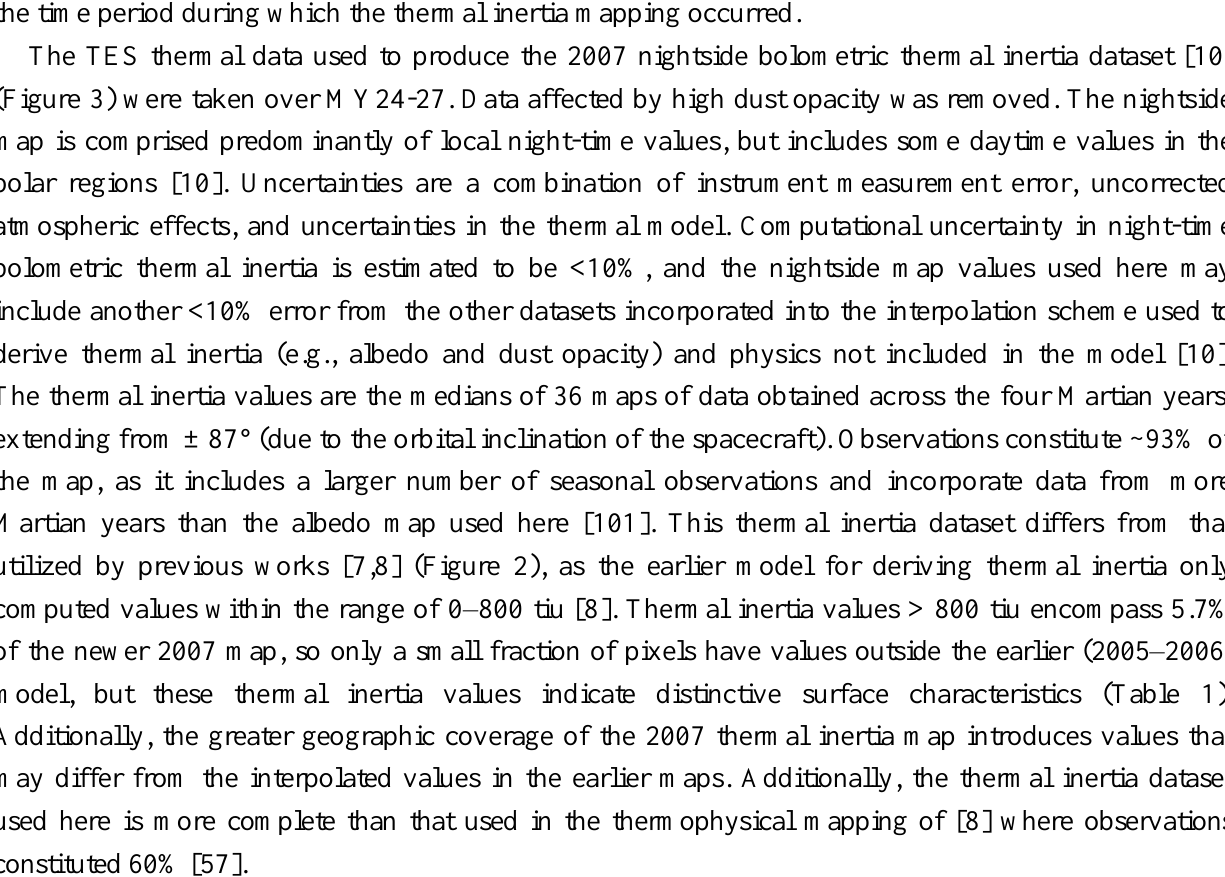
Figure 3. Comparison of the behaviour of Expectation Maximisation (EM) with a Gaussian Mixture Model (GMM) in producing 5–7 classes in thermal inertia and albedo. The 7 class results are analysed in this work. Contours are placed at counts: 40, 2 × 10 2 , 1 × 10 3 , 3 × 10 3